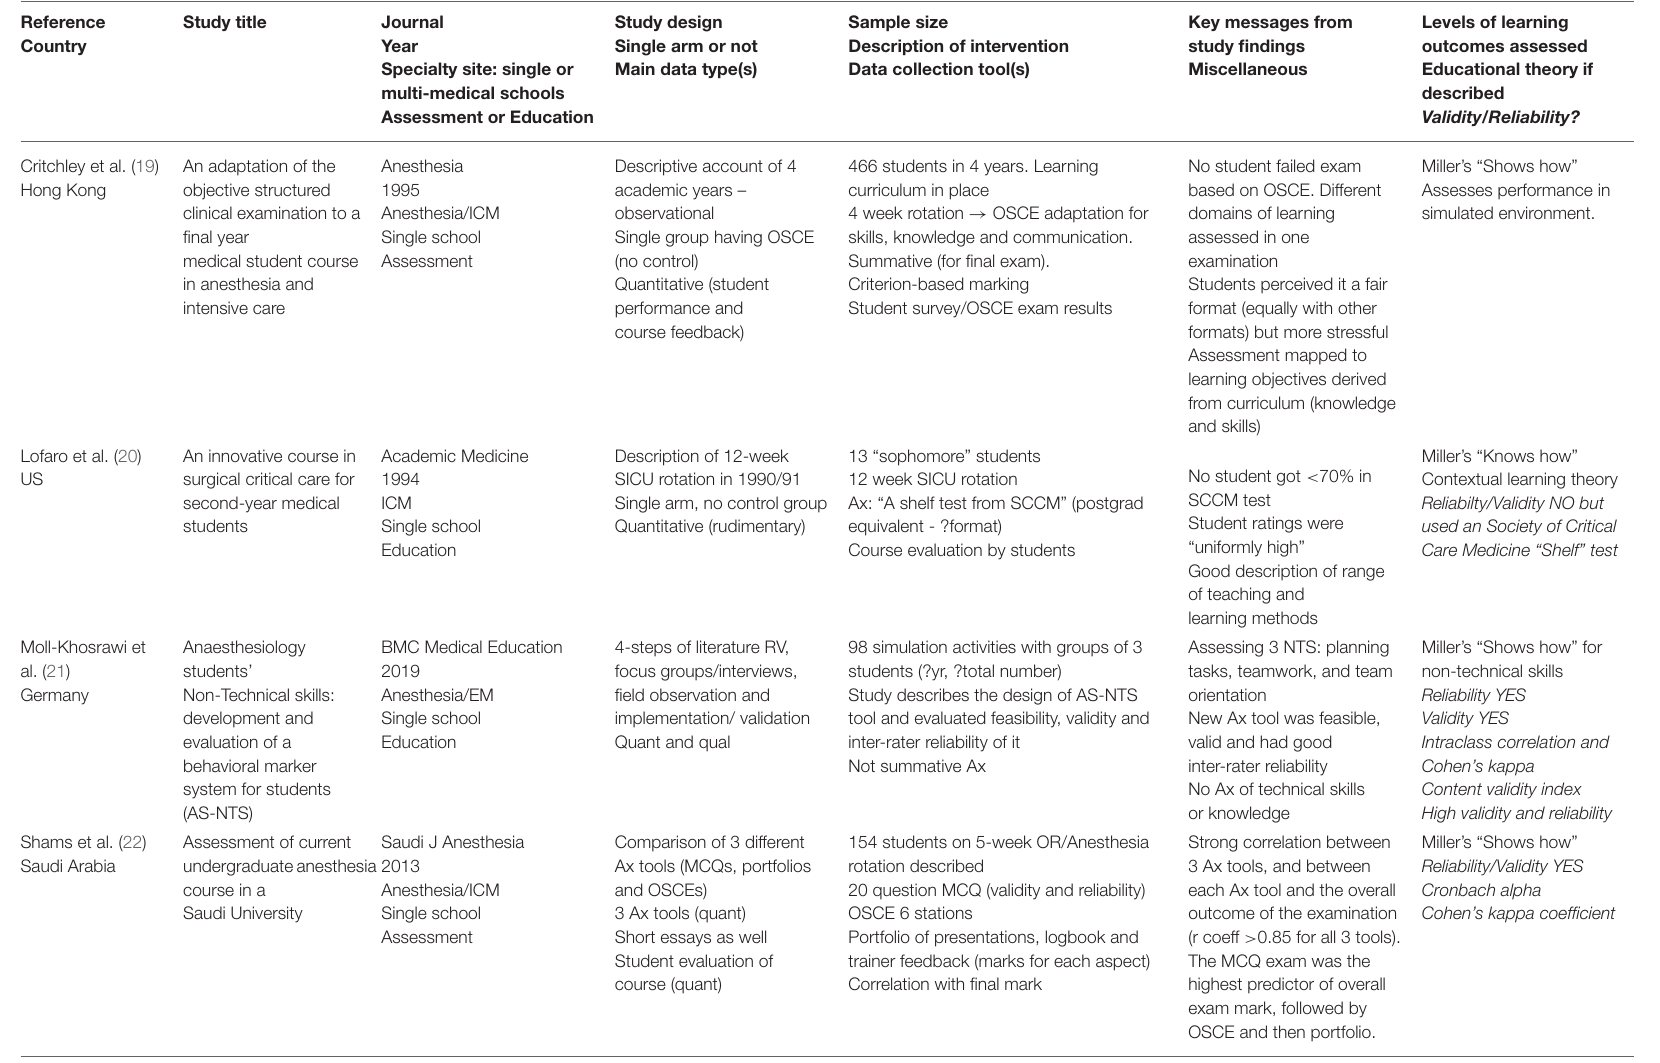
TABLE 1 | Summary of studies included in the scoping